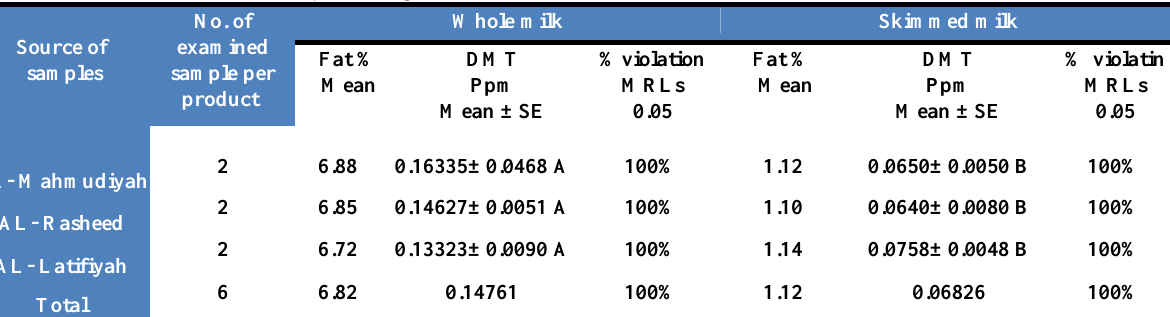
Table, 3: Comparison of the mean levels of DMT collected from different townships during the summer